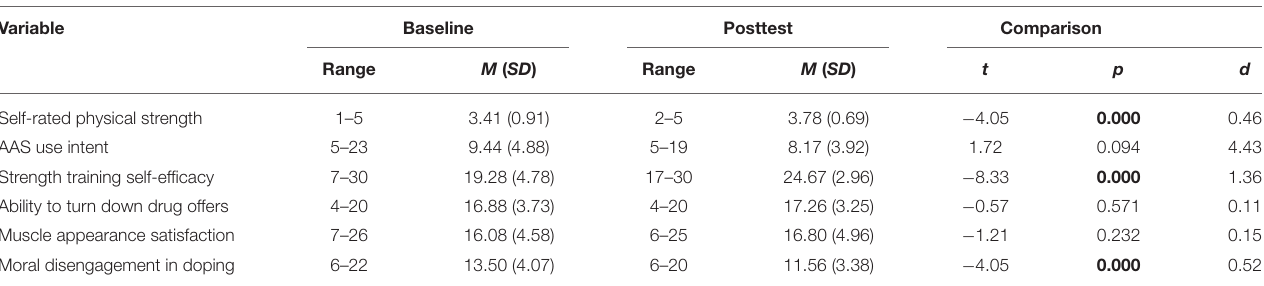
TABLE 6 | Comparison of baseline-posttest participants’ ( n = 52) scores.